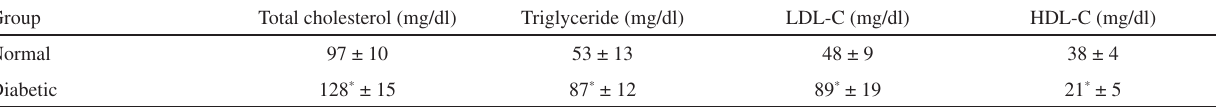
Table 1 - Comparison of serum lipid profiles in normal and STZ-induced diabetic rats. Group